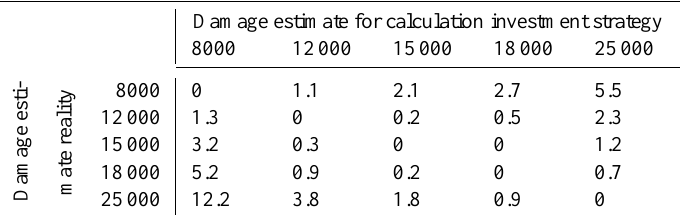
Table 4. Cost of a damage estimate error for this dike segment in EUR million (price level